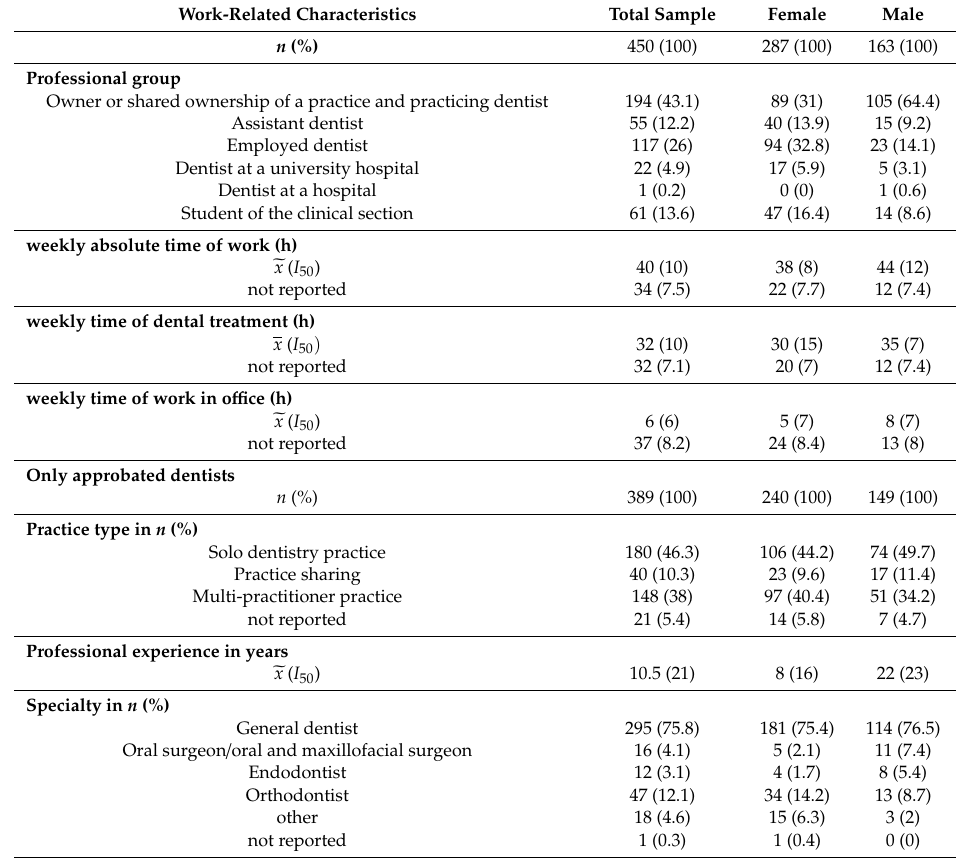
Table 3. Work-related characteristics of the total sample and comparison between female and male